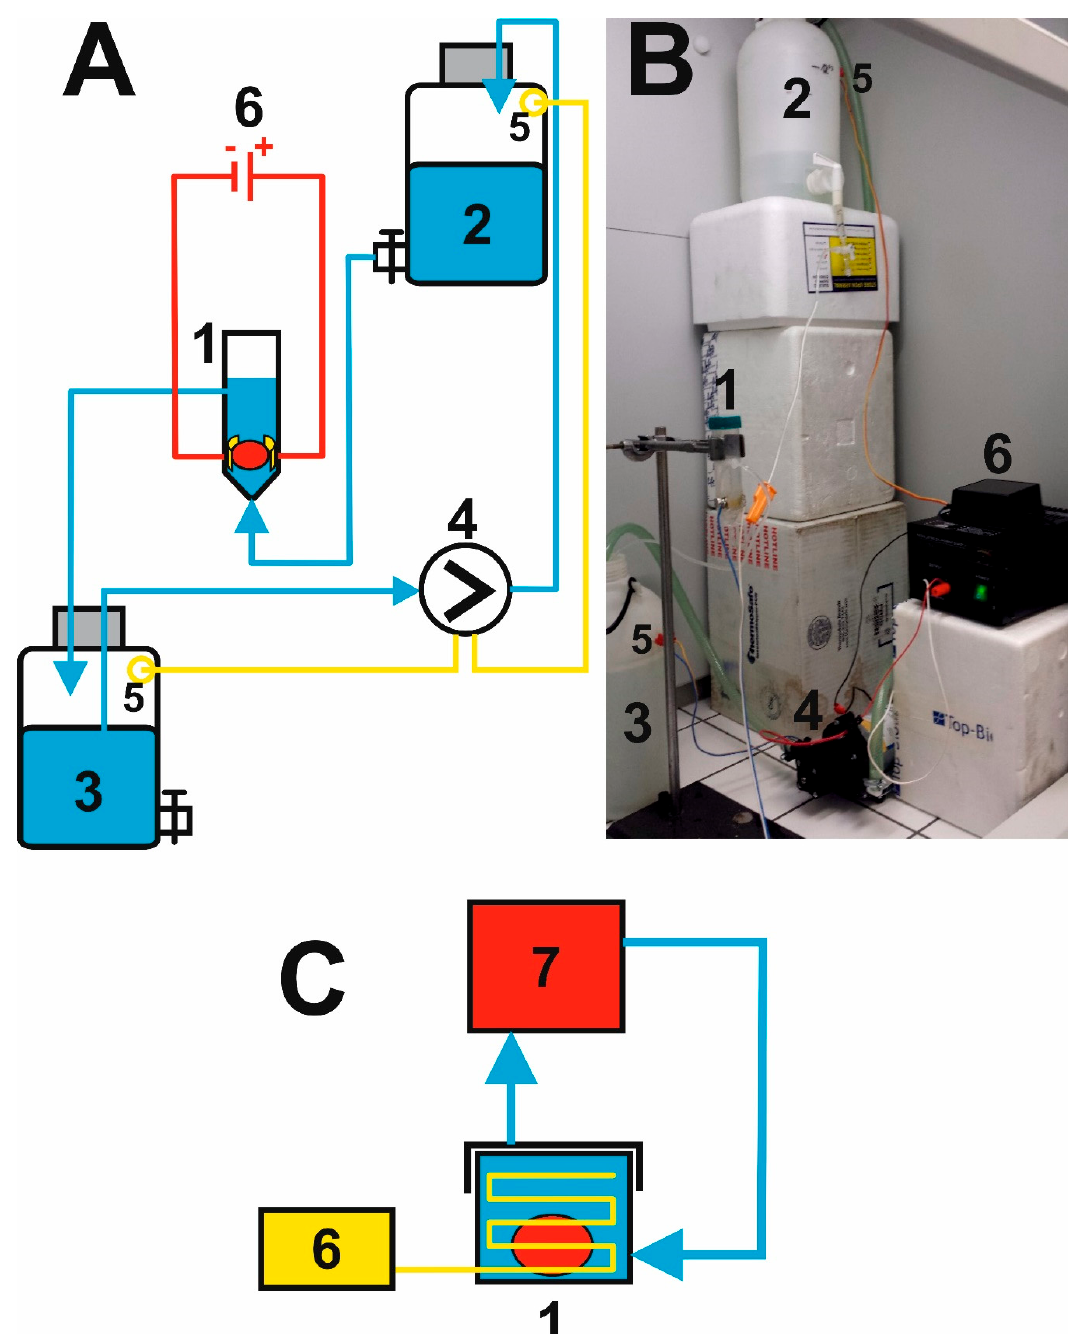
Figure 3. Scheme of the flow-through system ( A ): 1—vessel with the hydrogel, 2—upper and 3—lower bottle of washing solution, 4—membrane pump, 5—sensor, 6—source of direct current (DC) voltage; ( B ) photograph of the whole arrangement; ( C ) scheme of the original CLARITY apparatus for comparison: 1—vessel with the hydrogel, 6—source of DC voltage, 7—circulator of clearing solution including pumping and cooling system.